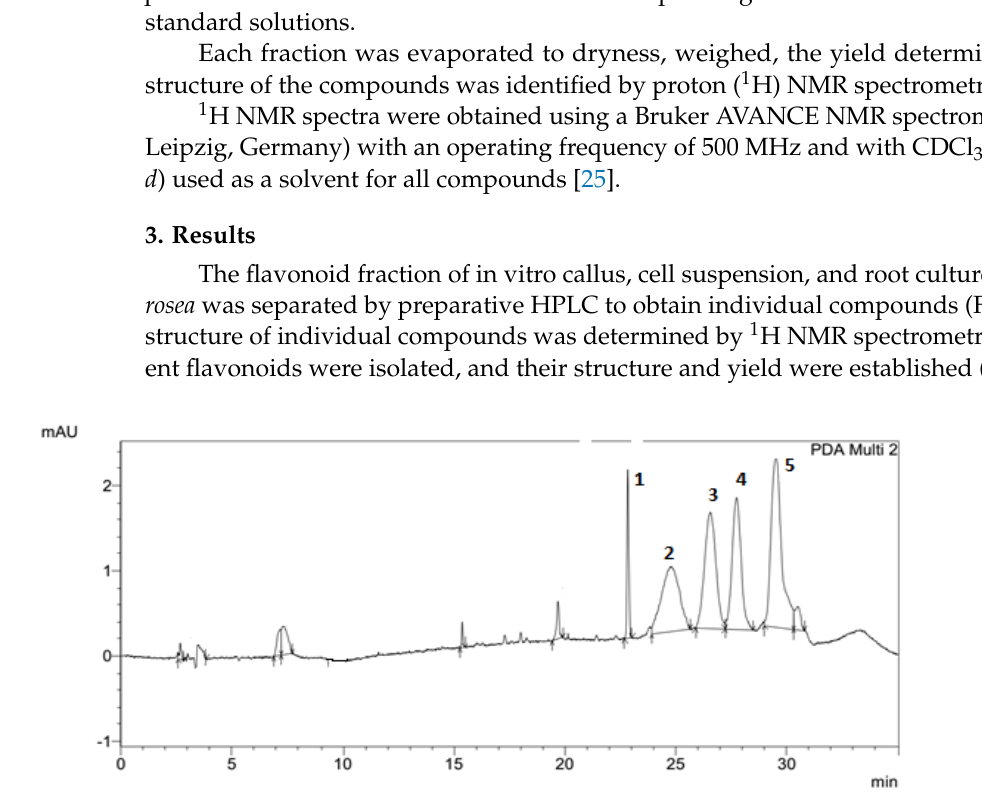
Figure 1. Results of preparative separation of flavonoid fractions from extracts of callus, cell suspension, and root cultures of Rhodiola rosea .